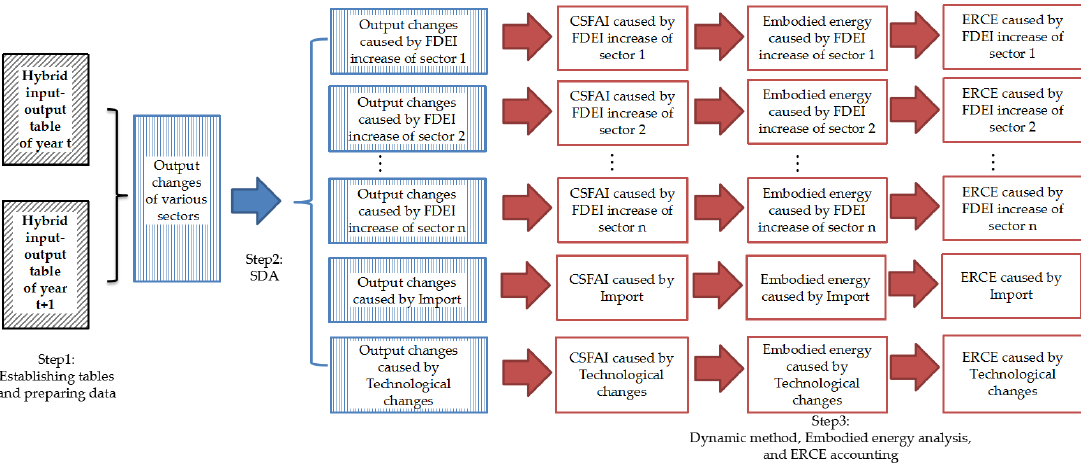
Figure 1. Three steps for establishing a dynamic hybrid input–output combined with structural decomposition analysis (DHI/O-SDA) model.